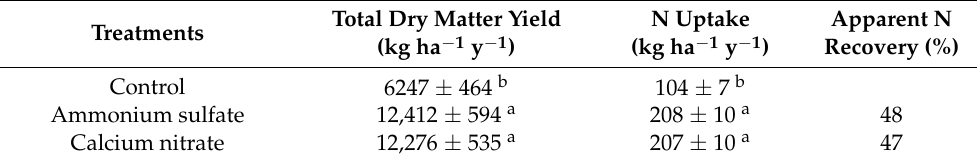
Table 3. Annual dry matter yield, N uptake and N recovery for different